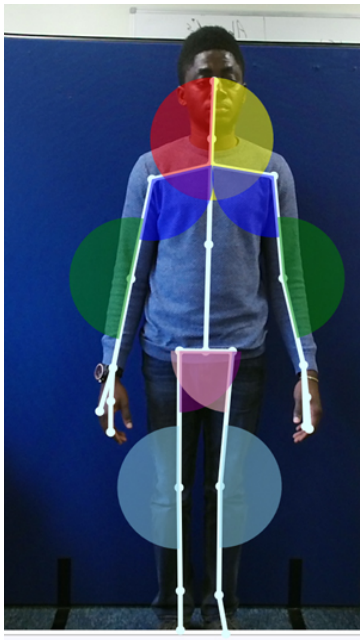
Figure 8. Skeleton and joint assessment in SAR. Similar joints are presented with the same colour.